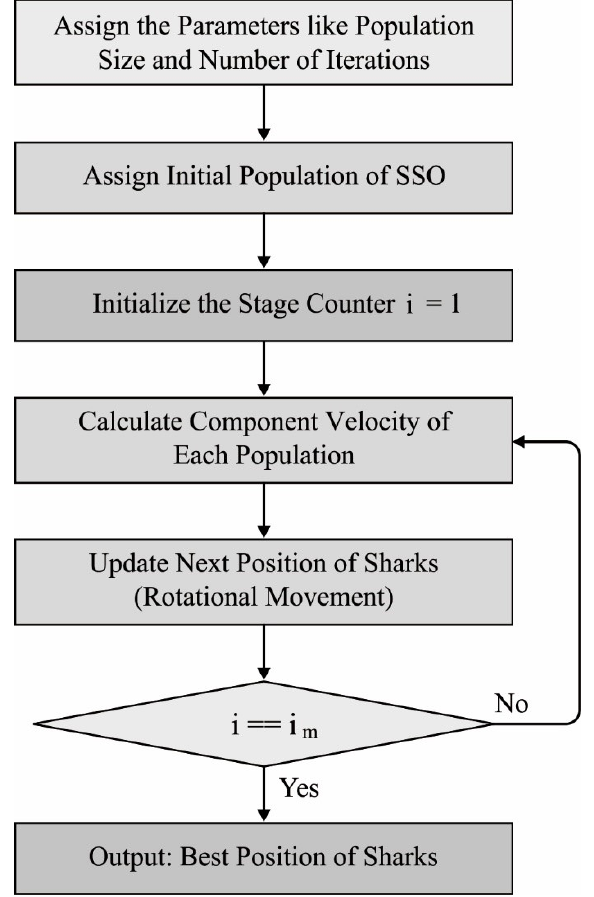
Figure 2. Flowchart of SOA.